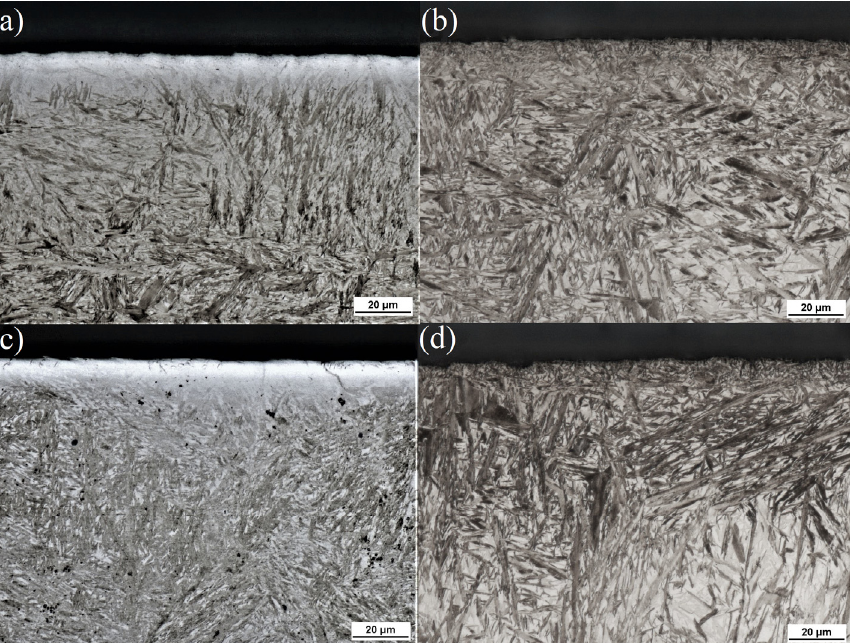
Figure 1. Martensitic microstructure of 10NiCrMo13-5 and 17CrNiMoCr 7-6 steels after: ( a , c ) low pressure carburizing process with chromium plating; ( b , d ) low pressure carburizing with aluminiza- tion. Etching performed with Mi1Fe, magnification ×